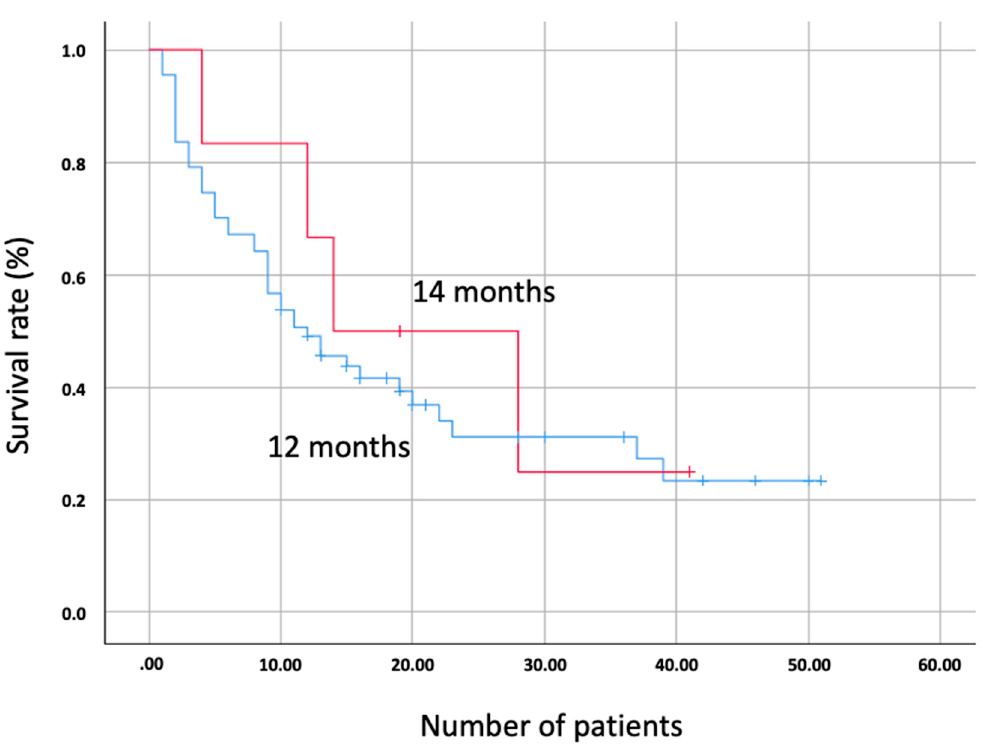
Figure 1. Kaplan–Meier curve showing the comparison of overall survival (OS) between patients with lost mismatch repair (MMR) system gene expression (red) and conserved (blue).